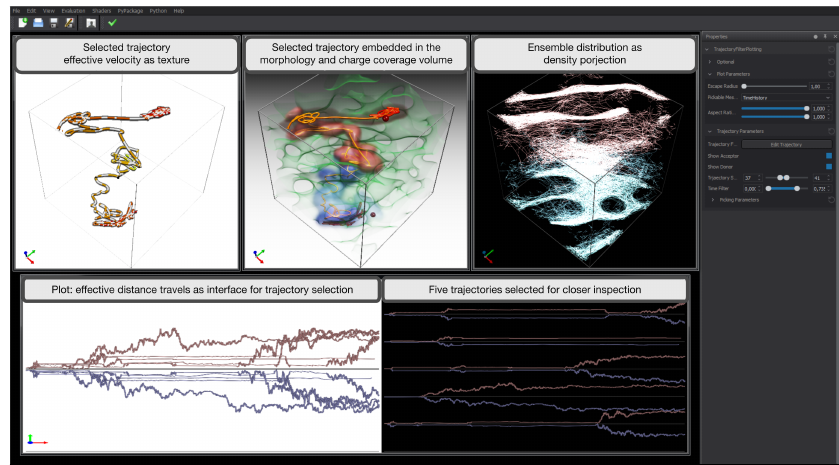
Figure 4. Screenshot of the system with annotations: It supports the exploration of the trajectory ensemble on different levels of detail. Single trajectories can be selected in qualitative plots (here effective distance a charge has traveled), which then can be inspected as isolated flow lines or with respect to the charge coverage volume within the morphology. An overview of the ensemble distribution provides contextual information.